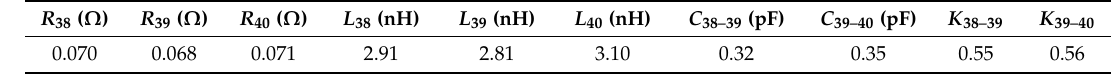
Table 5. Equivalent electrical parameters for the traces #38–40 of the